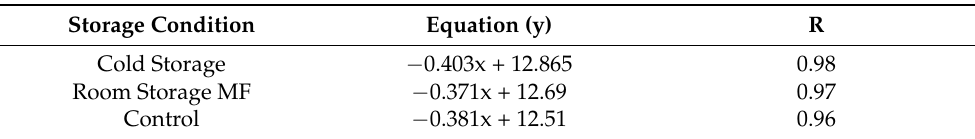
Table 2. Regression equations describing the variations in TSS between the different storage condi- tions of the Idared variety.